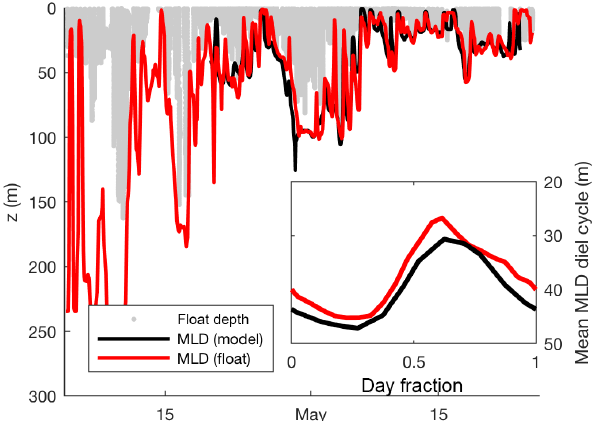
Figure 3. Hourly mixed-layer depth estimates calculated directly from float density measurements and from the Bagniewski et al. (2011) data assimilation model (black line), along with the depth of the float in mixed-layer mode (red line). Inset shows mean MLD diel cycle over the entire duration of the model (21 April–24 May). All MLD estimates use a density threshold of 0.01kgm − 3 to better approximate active mixing on an hourly